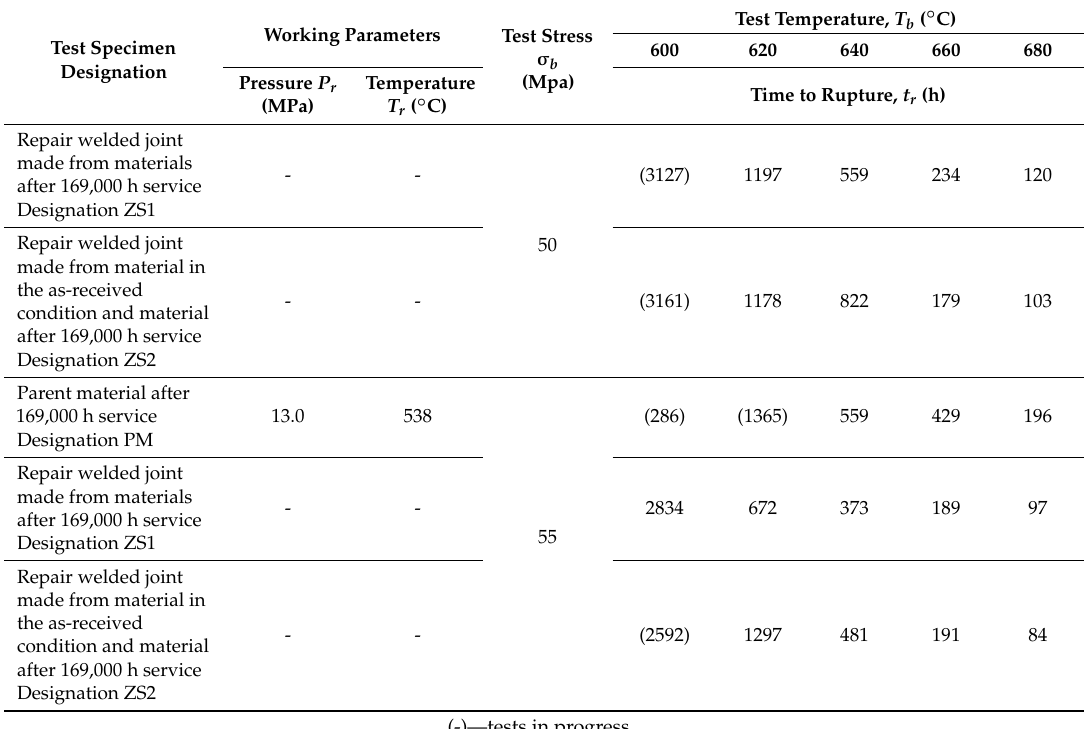
Table 5. Results of abridged creep tests.